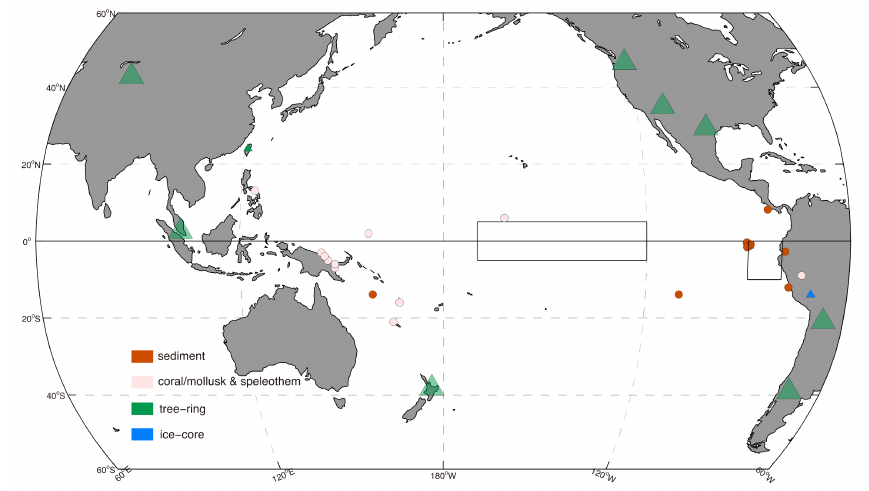
Figure 1. Location of circum-Pacific Paleo El Niño-Southern Oscillation (ENSO) proxy archives. Circles/triangles denote proxies that cover a period older/newer than 1 ka. Larger green triangles are for tree-ring synthesis clusters. Black boxes show Nino 3.4 region and Nino 1 + 2